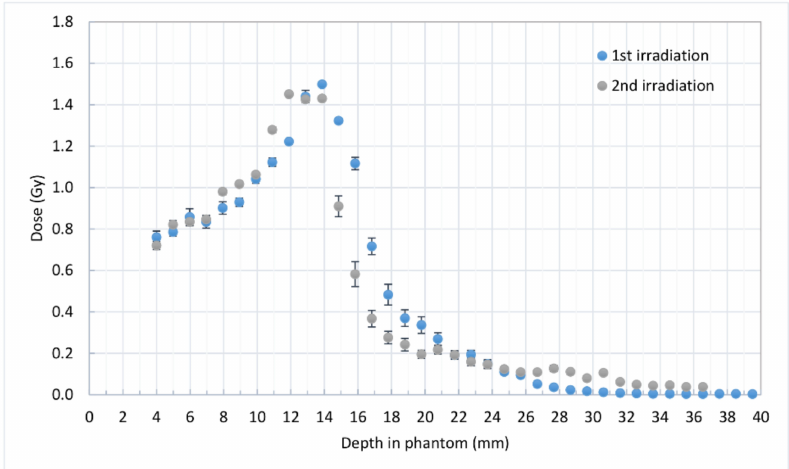
Figure 3. Comparison between proton beam depth–dose profiles reconstructed with the thermolumi- nescent dosimeters (TLDs-100) from row 1 in the 1st and 2nd irradiation stages. High dose differences occurred in the distal fall-off region of the Bragg peak, while lower deviations were observed